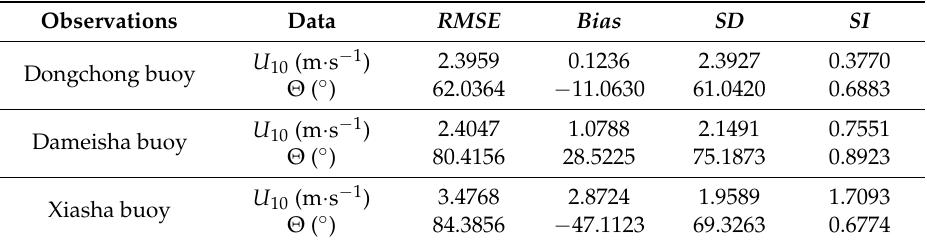
Table 7. Summary of the error indicators for the simulations from 1 to 8 April 2014.